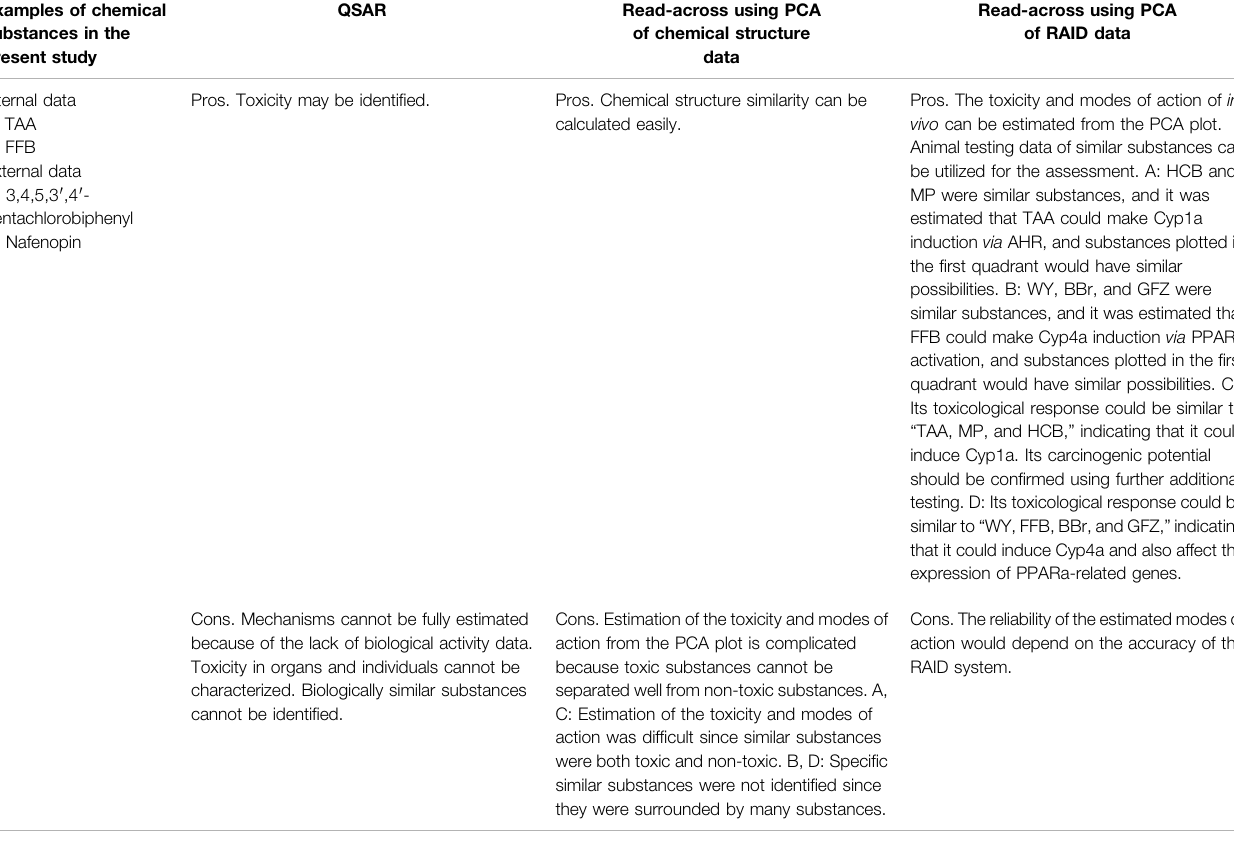
TABLE 5 | The relationships between the pros and cons of RAID and other methods for